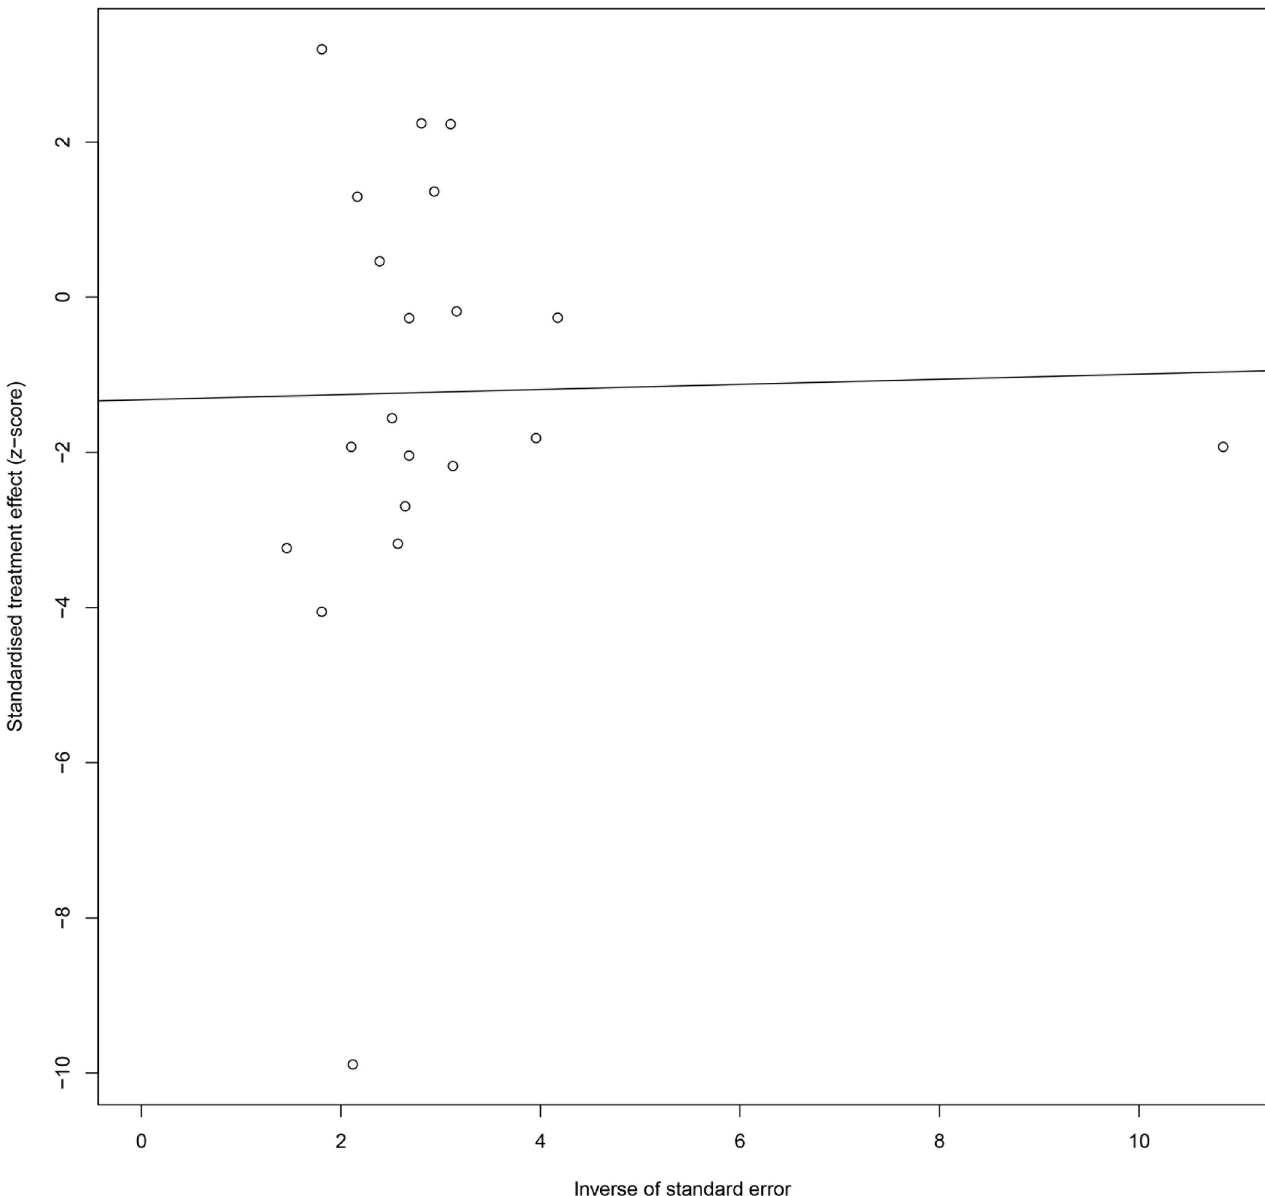
Fig 3. Egger funnel plots of 24-h urinary cortisol. Egger funnel plots to assess publication bias. Plots show study size as a function of effect size for studies included in the meta-analysis. The dots represent each